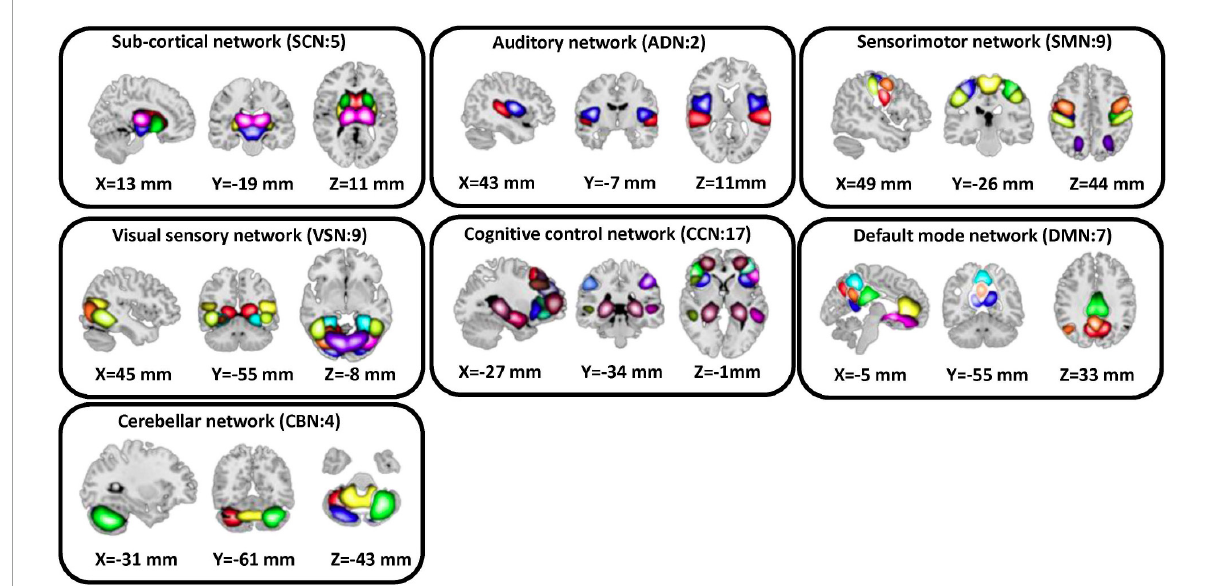
FIGURE2 Extracted independent components. Fifty three independent components estimated by NeuroMark pipeline. We put them in seven domains including subcortical network (SCN), auditory network (ADN), sensorimotor network (SMN), visual sensory network (VSN), cognitive control network (CCN), default mode network (DMN), and cerebellar network